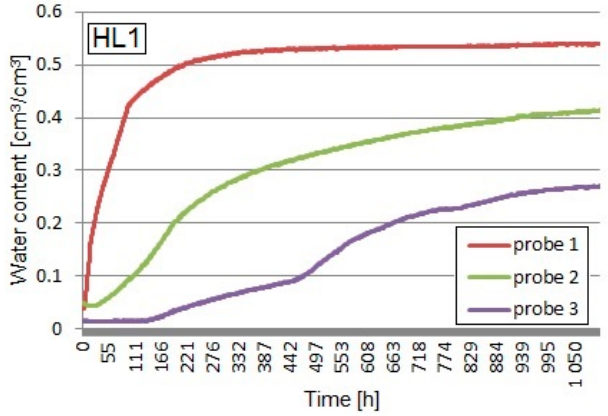
Figure 7. Capillary uptake of the HL1 composite.